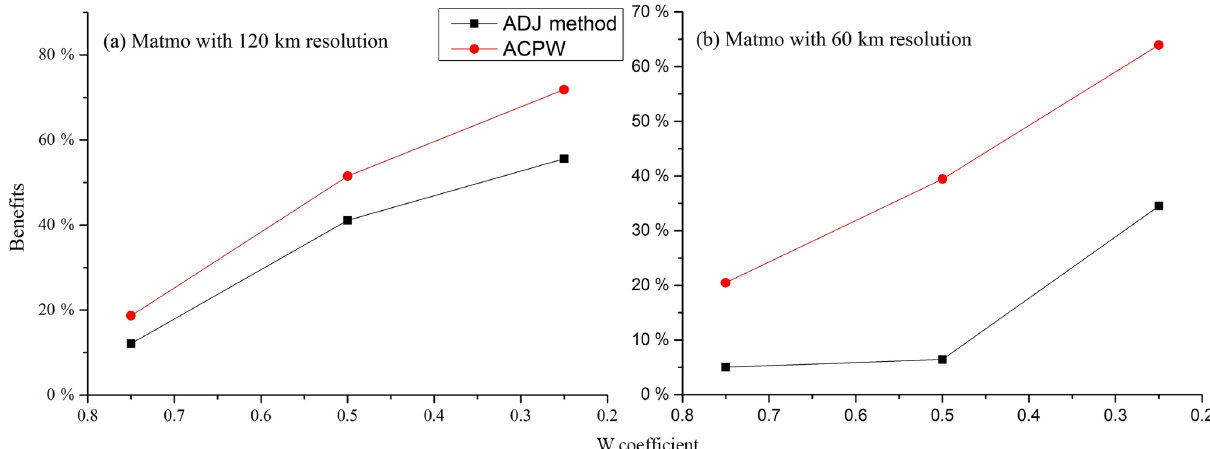
Figure 10. Benefits (in %) gained by reducing the CNOPs to W × CNOPs for the ADJ method and the ACPW algorithm across the entire domain for TC Matmo (2014). The x coordinate is the W coefficient values, and the y coordinate denotes the benefits (in %) derived from the two methods. The ADJ method is presented as the black line with squares, and the ACPW result is the red line with circles.